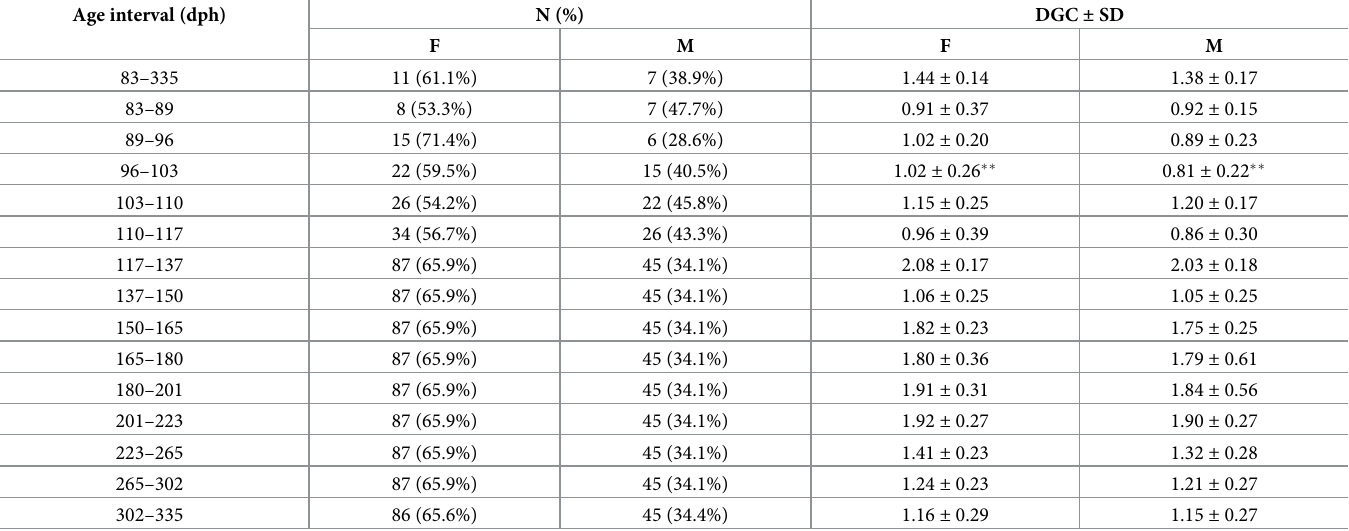
Table 2. Daily growth coefficient.